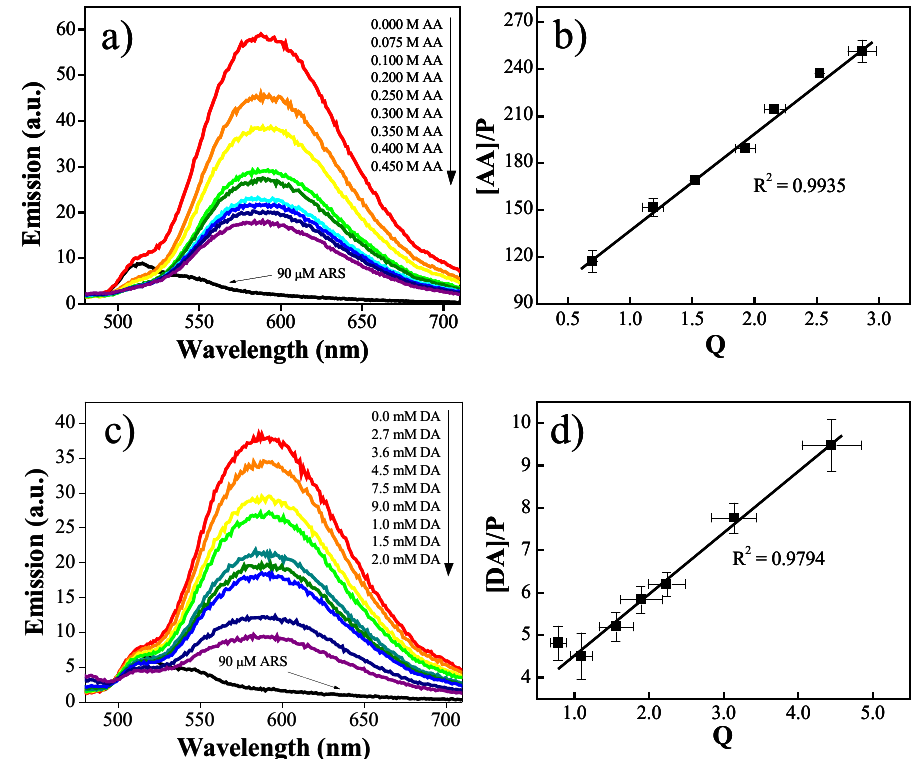
Figure 10. Fluorescent binding assay results of the affinity between PBA and AA and between PBA and DA: a) Fluorescence emission curves of the PBA-ARS complex upon titration with a range of AA concentrations; b) Linear correlation between [AA]/P and Q; c) Fluorescence emission curves of the PBA-ARS complex upon titration with a range of DA concentrations; d) Linear correlation between [DA]/P and Q. (Reproduced with permission from the American Chemical Society